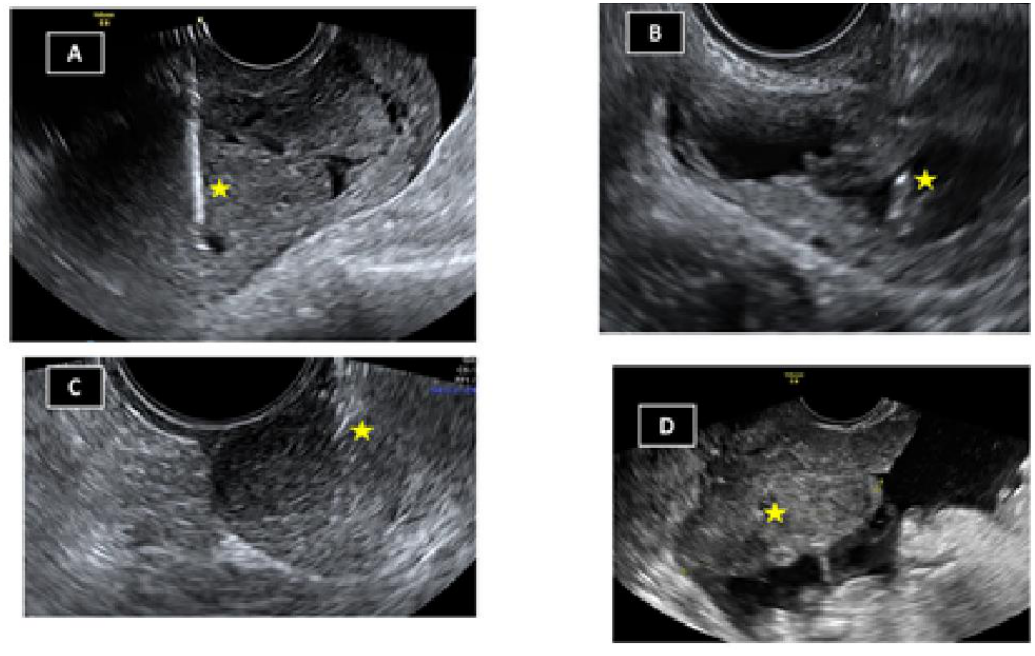
Figure 3. Examples of transvaginal ultrasound punctures/drainages/biopsies: ( A ) Myometrium; ( B ) tubal abscess; ( C ) vaginal nodule; ( D ) ovarian tumor with peritoneal carcinomatosis. Yellow asterisk: Needle.